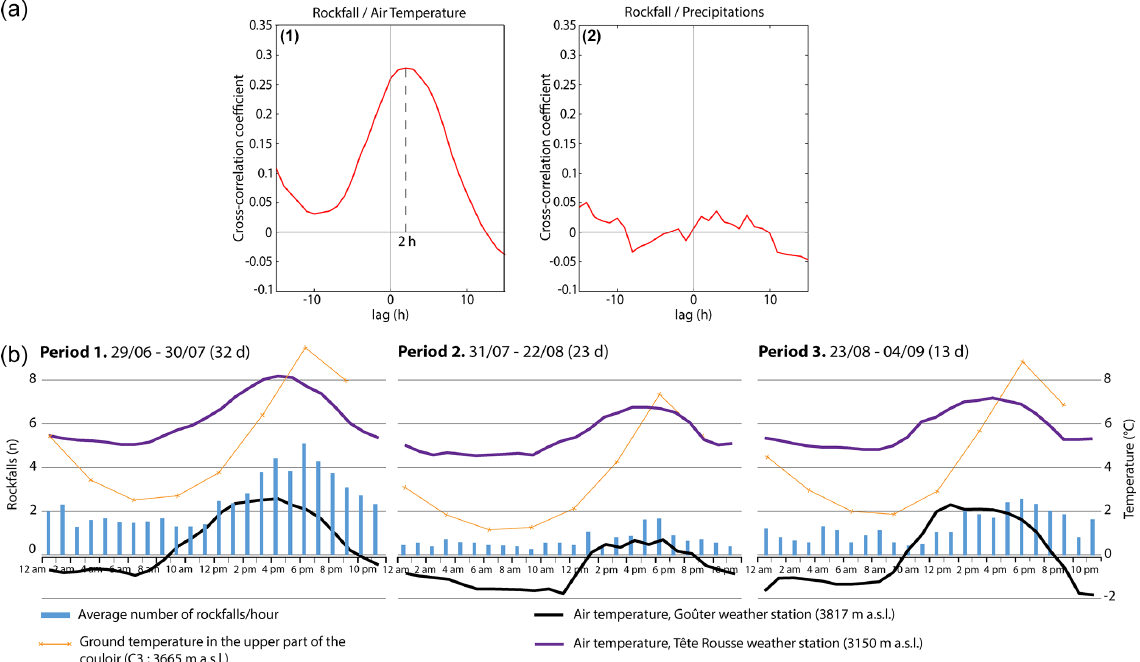
Figure 7. (a) Cross-correlation functions for the hourly rate of rockfalls and (1) the hourly temperature recorded at the Goûter refuge (3809ma.s.l.) and (2) hourly precipitation. The blue dashed line highlights the time delay of 2h between the hourly temperature and rockfall triggering. (b) Evolution over 24h, for Periods 1, 2 and 3, of (i) the average number of rockfalls per hour, (ii) the mean hourly ground temperature in the upper part of the couloir (C3), and (iii) the mean hourly air temperatures at the Tête Rousse and the Goûter weather